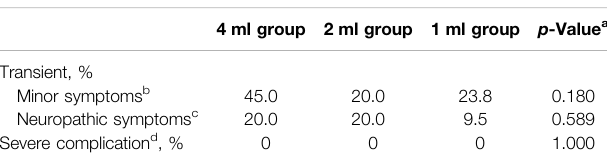
TABLE 4 | Adverse